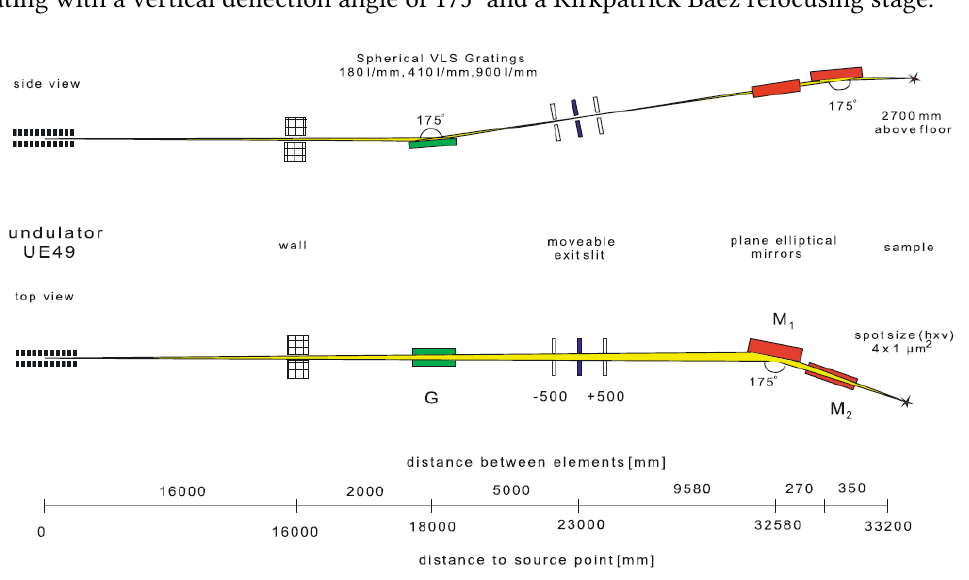
Figure 2: Optical layout of beamline UE49 SGM | RIXCS.